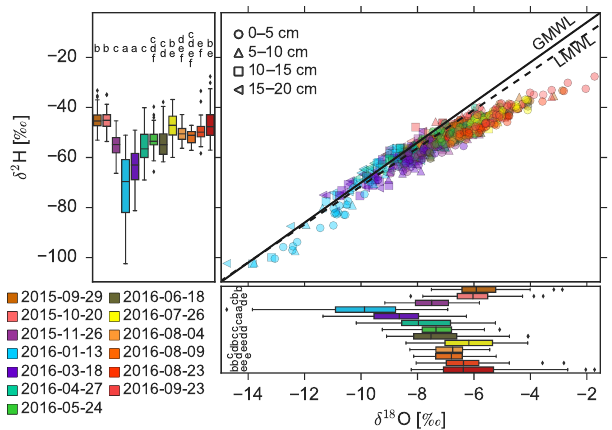
Figure 3. Dual isotope for all soil sampling campaigns and box plots for δ 18 O and δ 2 H bulked over all four sampling sites. The date of each soil sampling is indicated by colors. The depth of the soil samples is shown by different symbols in the dual-isotope plot. Sampling dates that do not have significantly different isotope data according to the post hoc Dunn test are indicated by the same letter next to the box plots. For example, the letter “a” at the box plots from sampling day 13 January 2016 and 18 March 2016, indicate that the soil water isotopes do not differ significantly from each other, but to all other sampling days. The global meteoric water line (GMWL, δ 2 H = 8 × δ 18 O + 10) is shown with a solid line and lo- cal meteoric water line (LMWL, δ 2 H = 7.6 × δ 18 O + 4.7) is plotted with a dashed